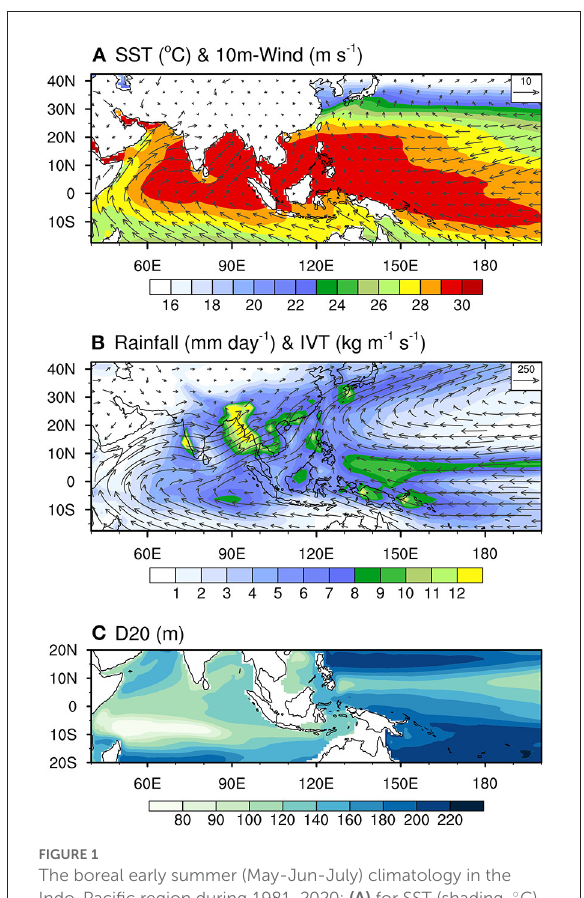
FIGURE1 The boreal early summer (May-Jun-July) climatology in the Indo-Pacific region during 1981-2020: (A) for SST (shading, ◦ C) from HadISST (Rayner et al., 2003) and 10 meter wind (vector, m s − 1 ) from ERA5 (Hersbach et al., 2020), (B) for rainfall (shading, mm day − 1 ) from GPCP (Adler et al., 2003) and vertical integral of zonal and meridional water vapor flux (abbreviated as IVT, vector, kg m − 1 s − 1 ) from ERA5, and (C) for thermocline depth calculated as the depth of 20 ◦ C isotherm of sea water temperature (D20, shading, m) from GODAS reanalysis (Behringer et al.,